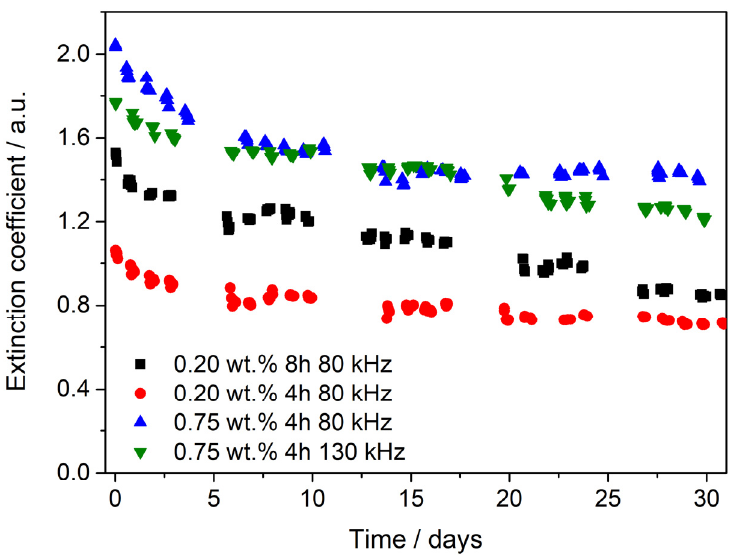
ffi cient values at λ = 629 nm from UV-Vis spectra over Figure 4. Evolution of the extinction coefficient values at λ = 629 nm from UV-Vis spectra over time. Figure 4. Evolution of the extinction coe